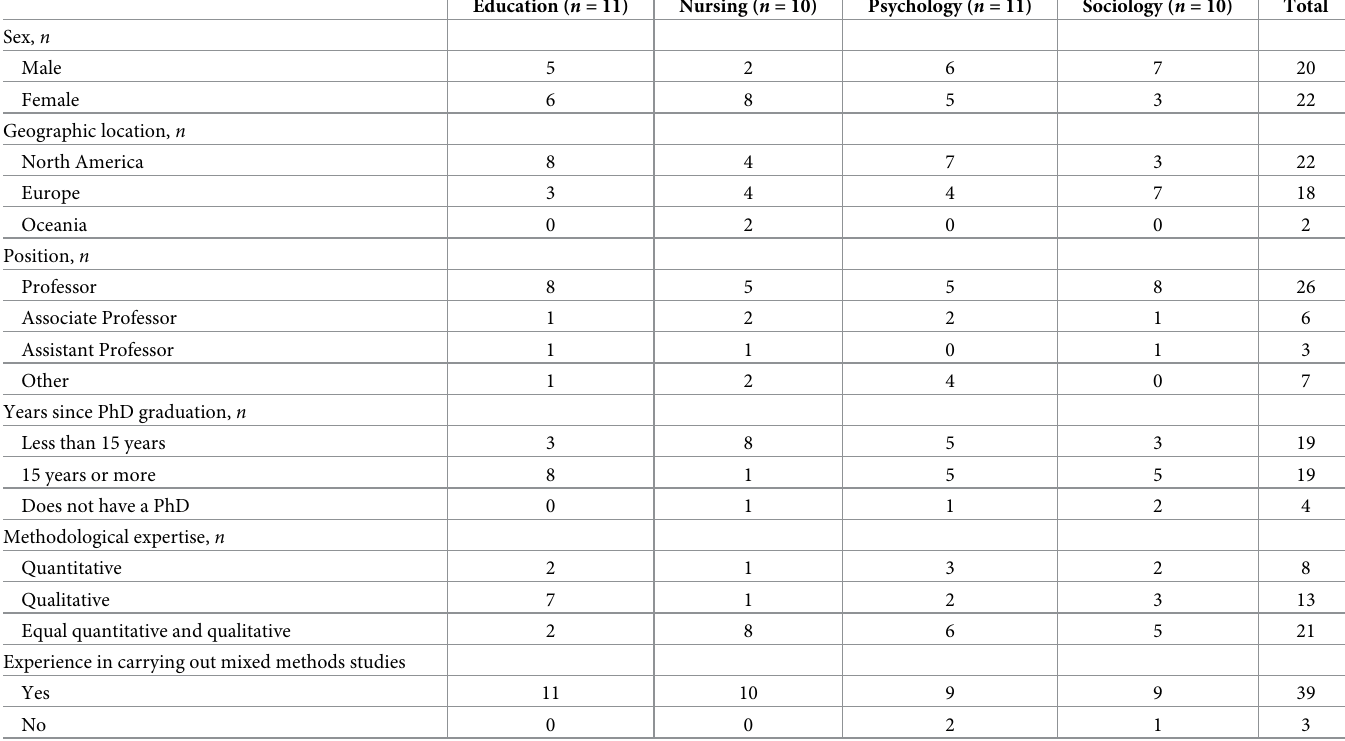
Table 1. Characteristics of participants by discipline (N =